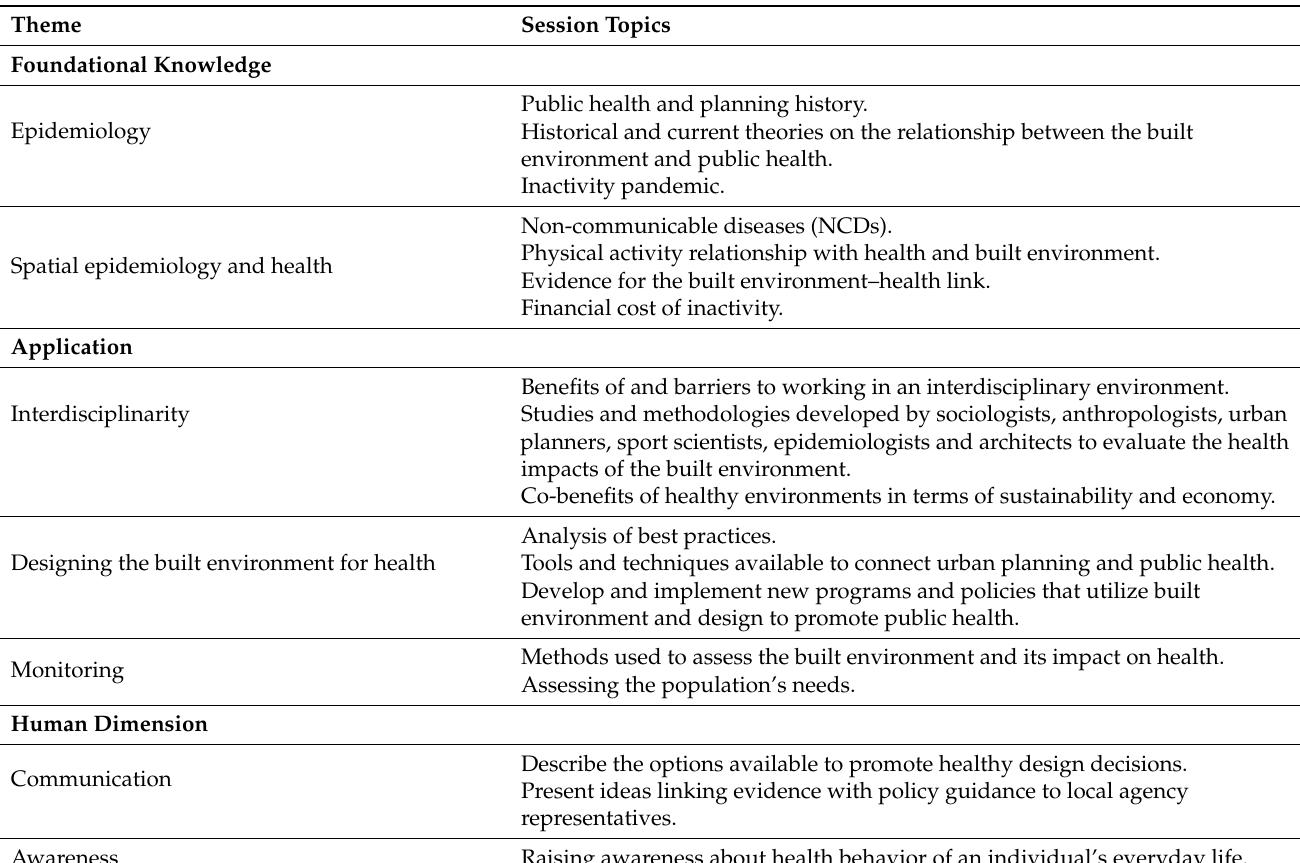
Table 1. A proposal for a core